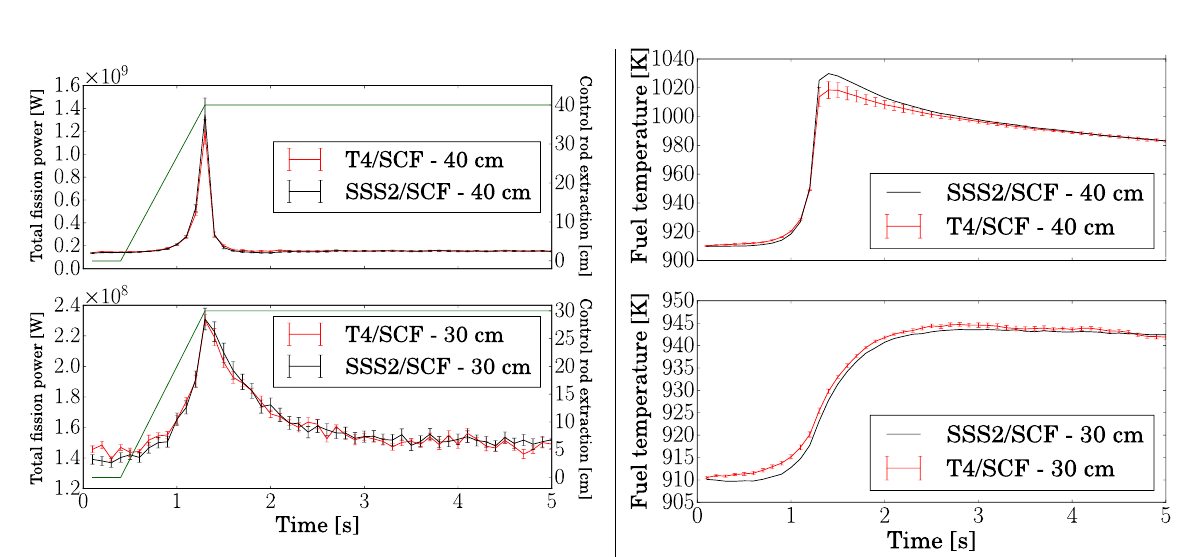
Figure 2: Simulation results of the TMI-1 3x3 mini-core computed with TRIPOLI-4 / SUBCHANFLOW (red lines) and Serpent 2 / SUBCHANFLOW (black lines), with control rods progressively extracted by 40 cm (top) and 30 cm (bottom). The reactivity insertion induced by the rods extraction is represented in green. Left: time evolution of the total power (in watts). Right: time evolution of the average fuel rod temperature (in kelvins).